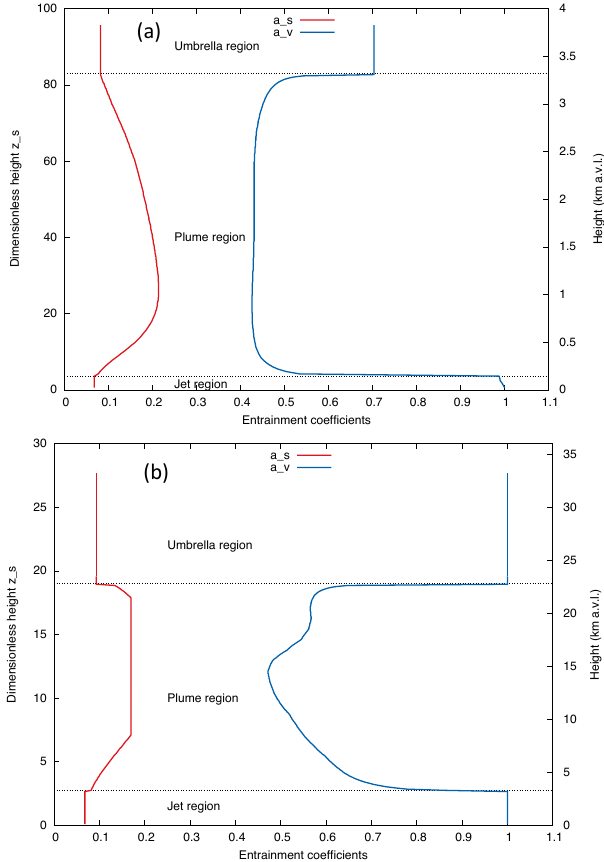
Figure 3. Entrainment coefficients α s (red) and α v (blue) versus height for weak (a) and strong (b) plumes under a wind profile. The vertical dashed lines indicate the transition between the differ- ent eruptive column regions. Weak plume simulation with: ˆ M o = 1 . 5 × 10 6 kgs − 1 , ˆ u o = 135ms − 1 , ˆ T o = 1273K, ˆ x wo = 0 . 03. Strong plume simulation with: ˆ M o = 1 . 5 × 10 9 kgs − 1 , ˆ u o = 300ms − 1 , ˆ T o = 1153K, ˆ x wo = 0 .